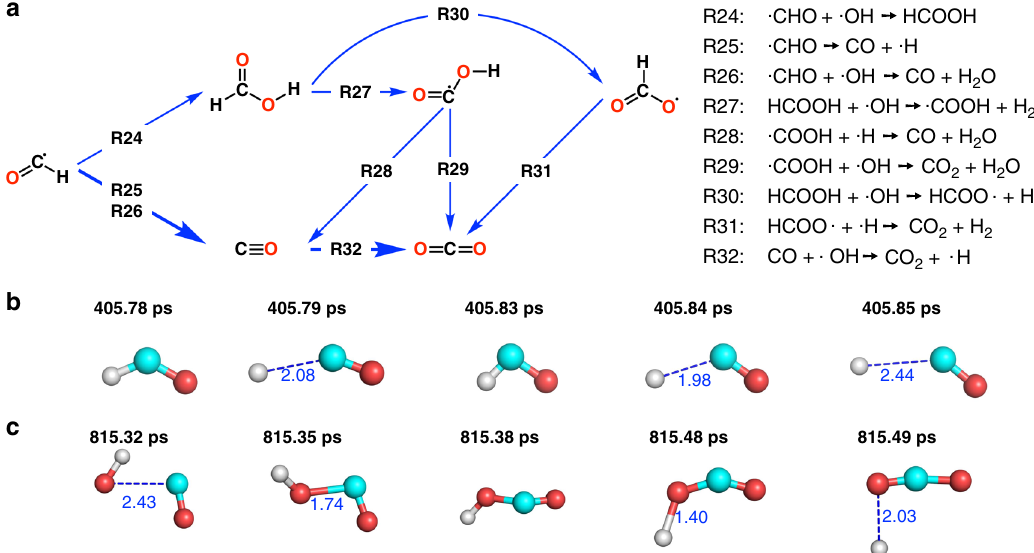
Fig. 4 Production of CO and CO 2 . a Main reaction pathways for the formation of CO and CO 2 . b The real-time trajectory of the reaction ·CHO → CO + ·H. Atoms in cyan, red and gray colors are carbon, oxygen and hydrogen, respectively. c The real-time trajectory of the reaction CO + ·OH → CO 2 + ·H. De fi nition of colored atoms is the same as in ( b